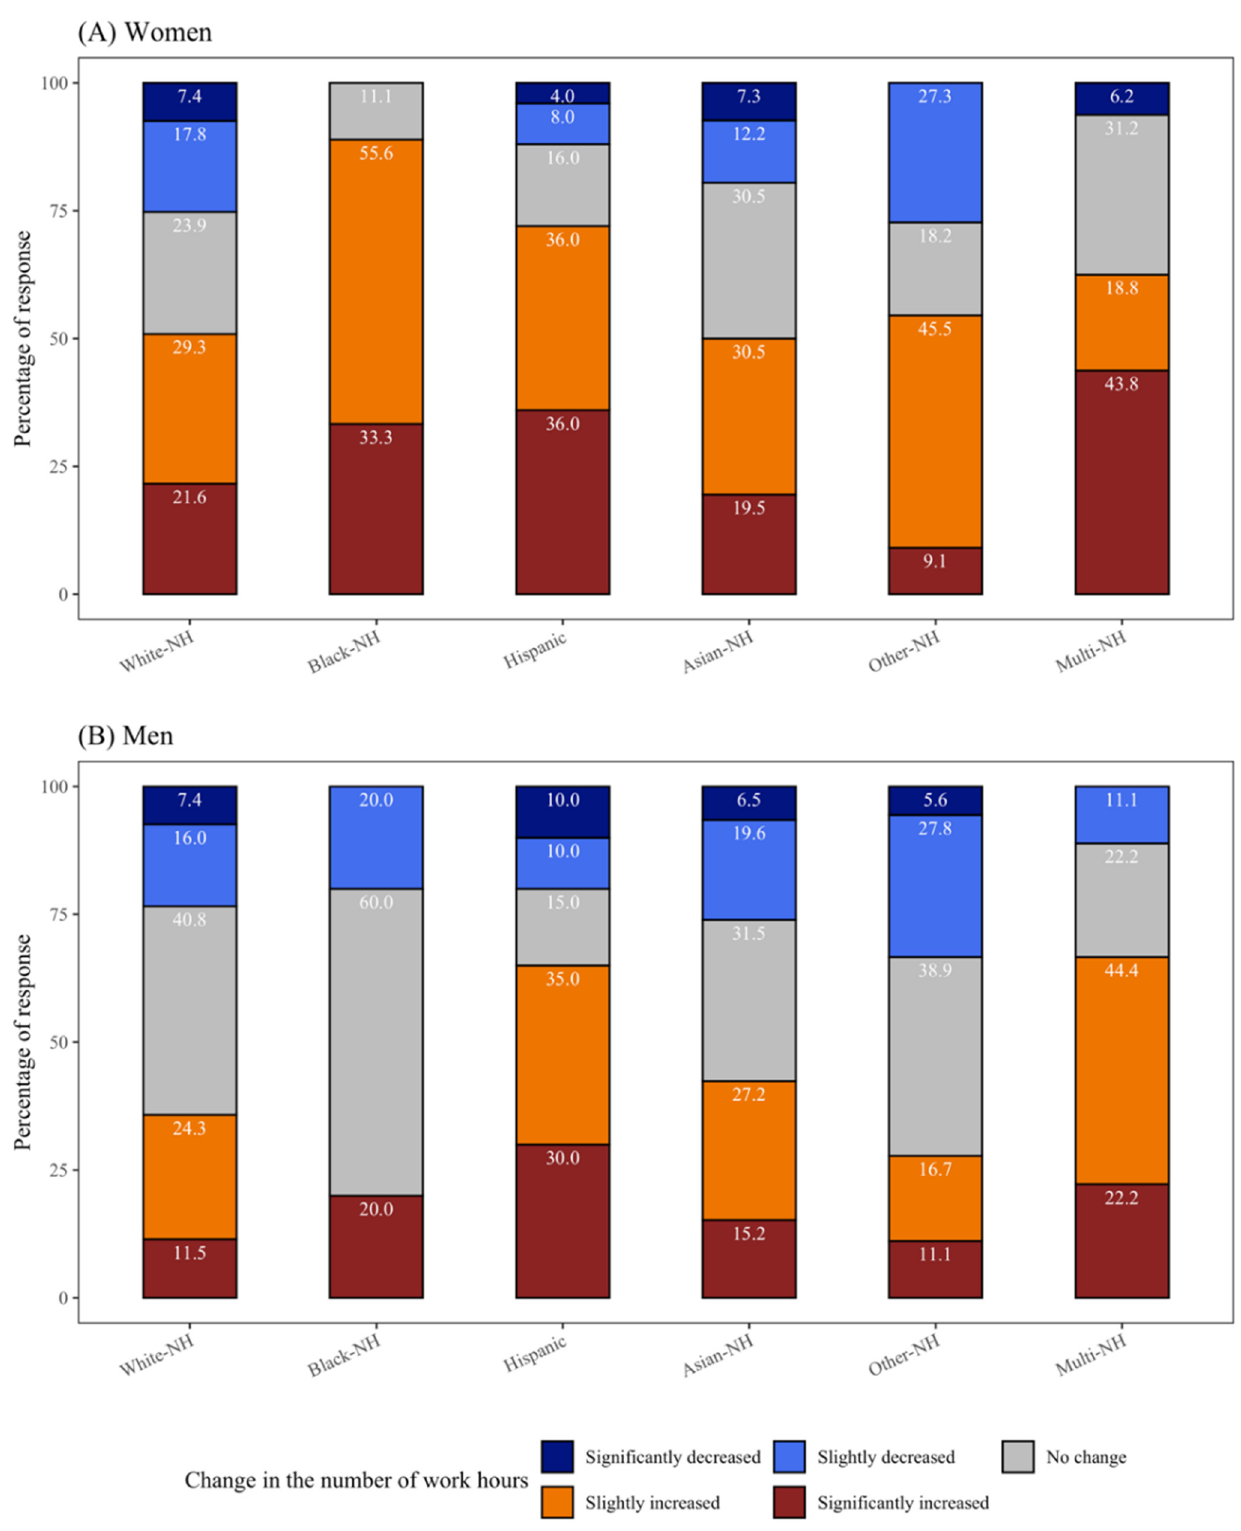
Figure 1. Changes in the number of work hours during the pandemic compared to pre-pandemic periods by race, stratified by gender: ( A ) women; ( B ) men.